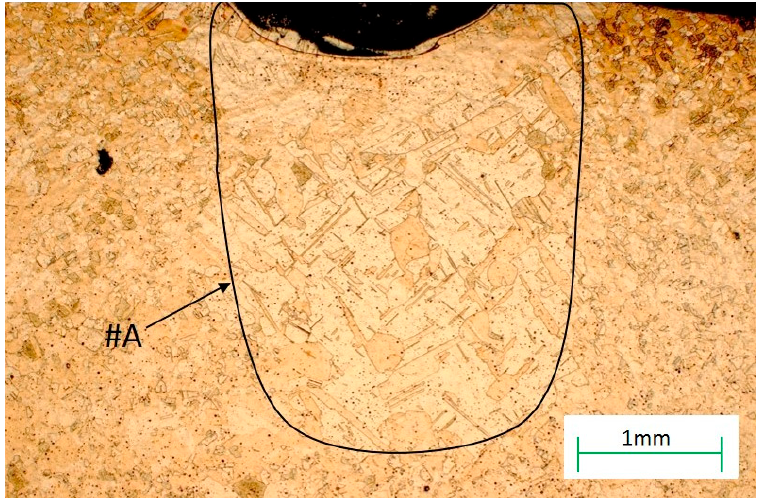
Figure 10. Linear chemical composition analysis at the zone boundary. The scale bar is 85 µm.